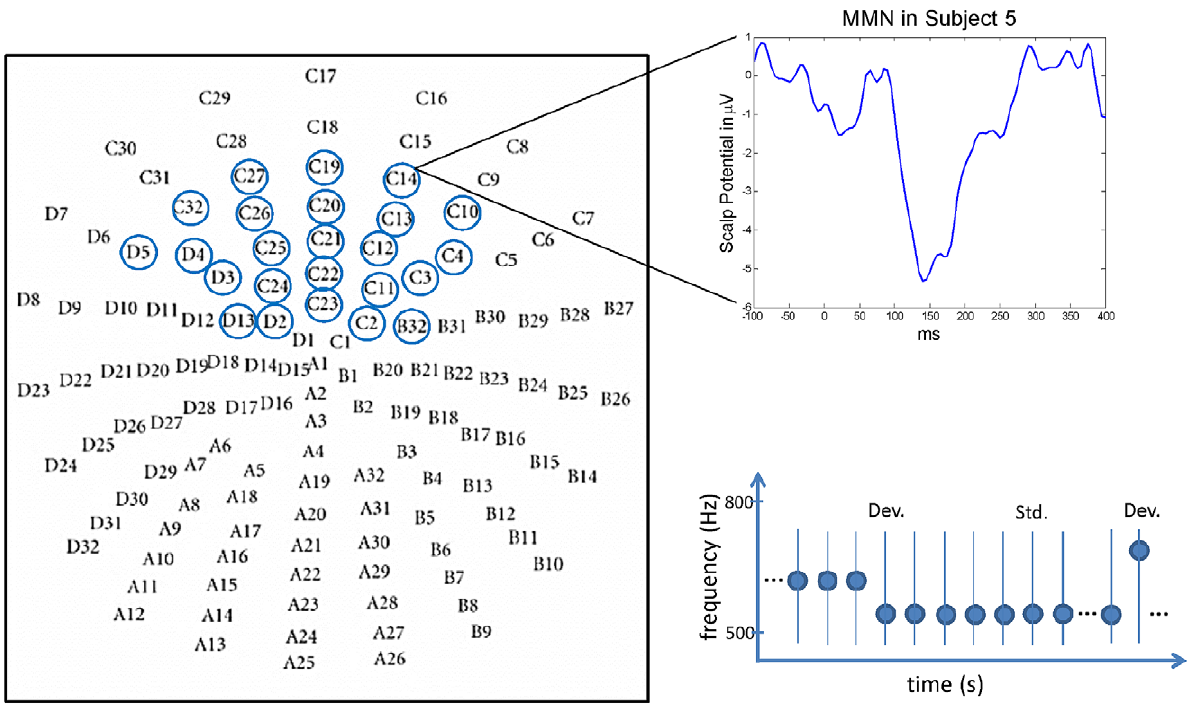
Figure 1. Data acquisition: EEG layout, pre-defined electrodes, sample waveform, and stimulus sequences. The left panel shows the layout of the 128 electrodes of the EEG setup. The blue circles highlight the pre-defined fronto-central electrodes. The upper right panel shows a difference wave containing the MMN. The lower right panel illustrates the structure of the tone sequences presented in the roving oddball experiment. Tones are shown as black disks whose vertical position indicates sound frequency. The first tone presented after a train of tones of a different frequency is called a deviant (D).